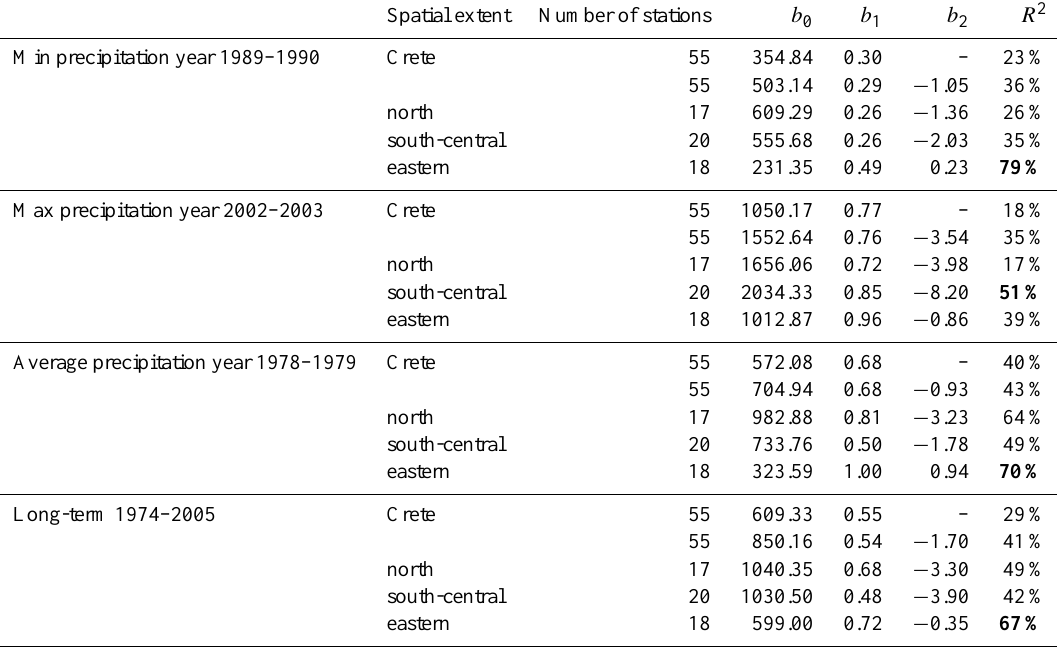
Table 3. Simple and linear regression for Crete and its parts for different years. The highest R 2 values are in bold. Spatial extent Number of